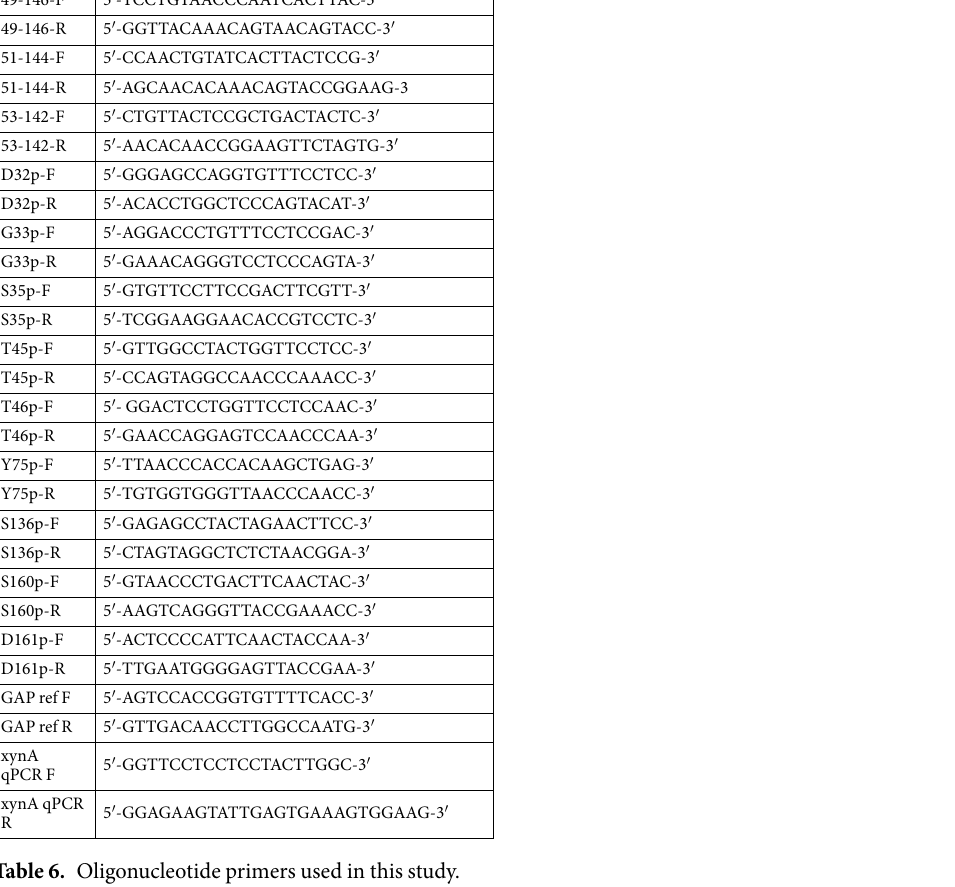
Table 6. Oligonucleotide primers used in this